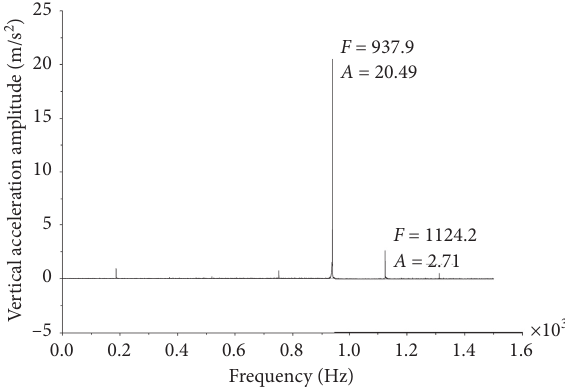
Figure 5: Vertical acceleration of the original model. Table 4 indicates that the theoretical meshing frequency